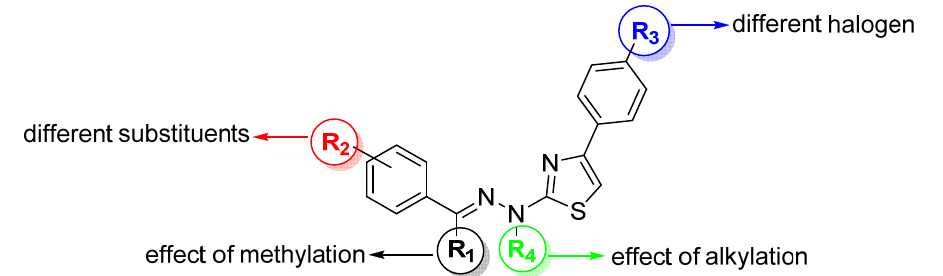
Figure 3. Illustration of the design of 4-substituted-2-hydrazineylthiazole derivatives showing the different structural features examined.